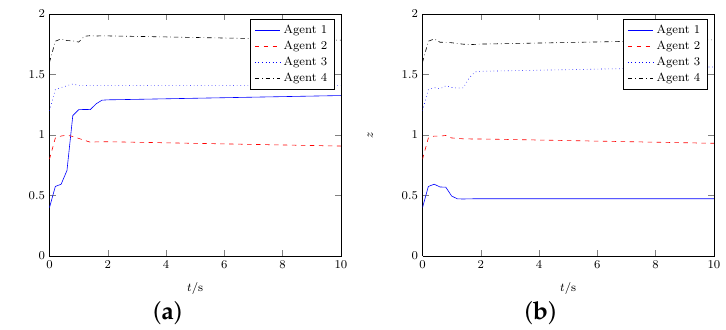
Figure 6. The trajectories of four mobile agents under different missing measurement probability. ( a ) q i ( t ) = 0.2. ( b ) 1 q i ( t ) = 0. 1 − −